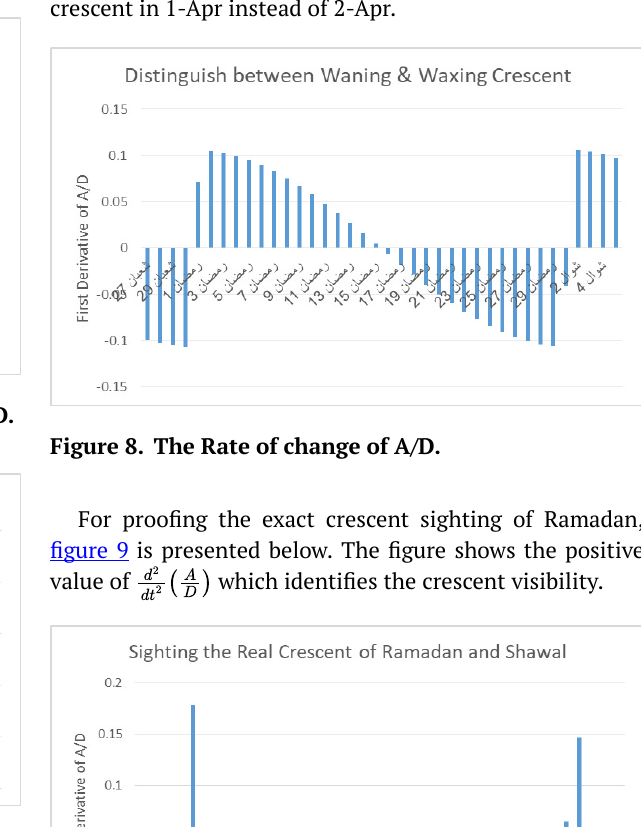
Figure 6. Positive Values of (A/D) \\ Proves The Exact Crescent Sighting.